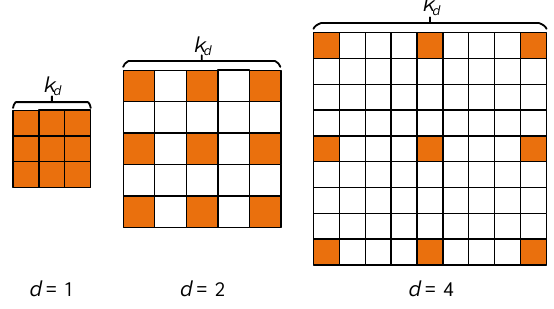
Figure 2 Extended Convolution with Different Dilated Rates Figure 2. Dilated Convolution with Different Dilated